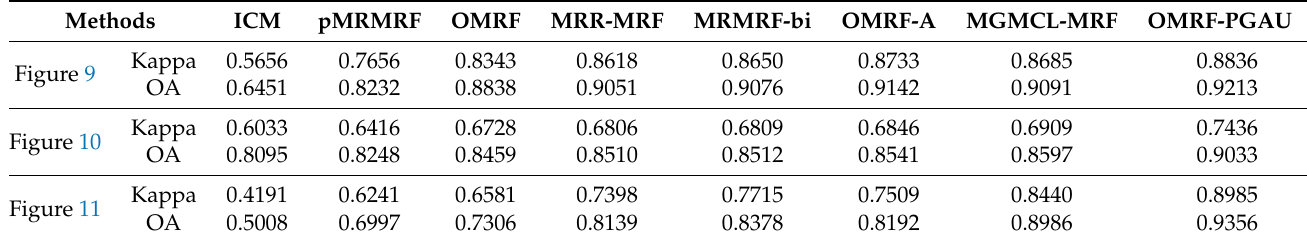
Table 2. Quantitative indicators of eight comparison methods for three SPOT5